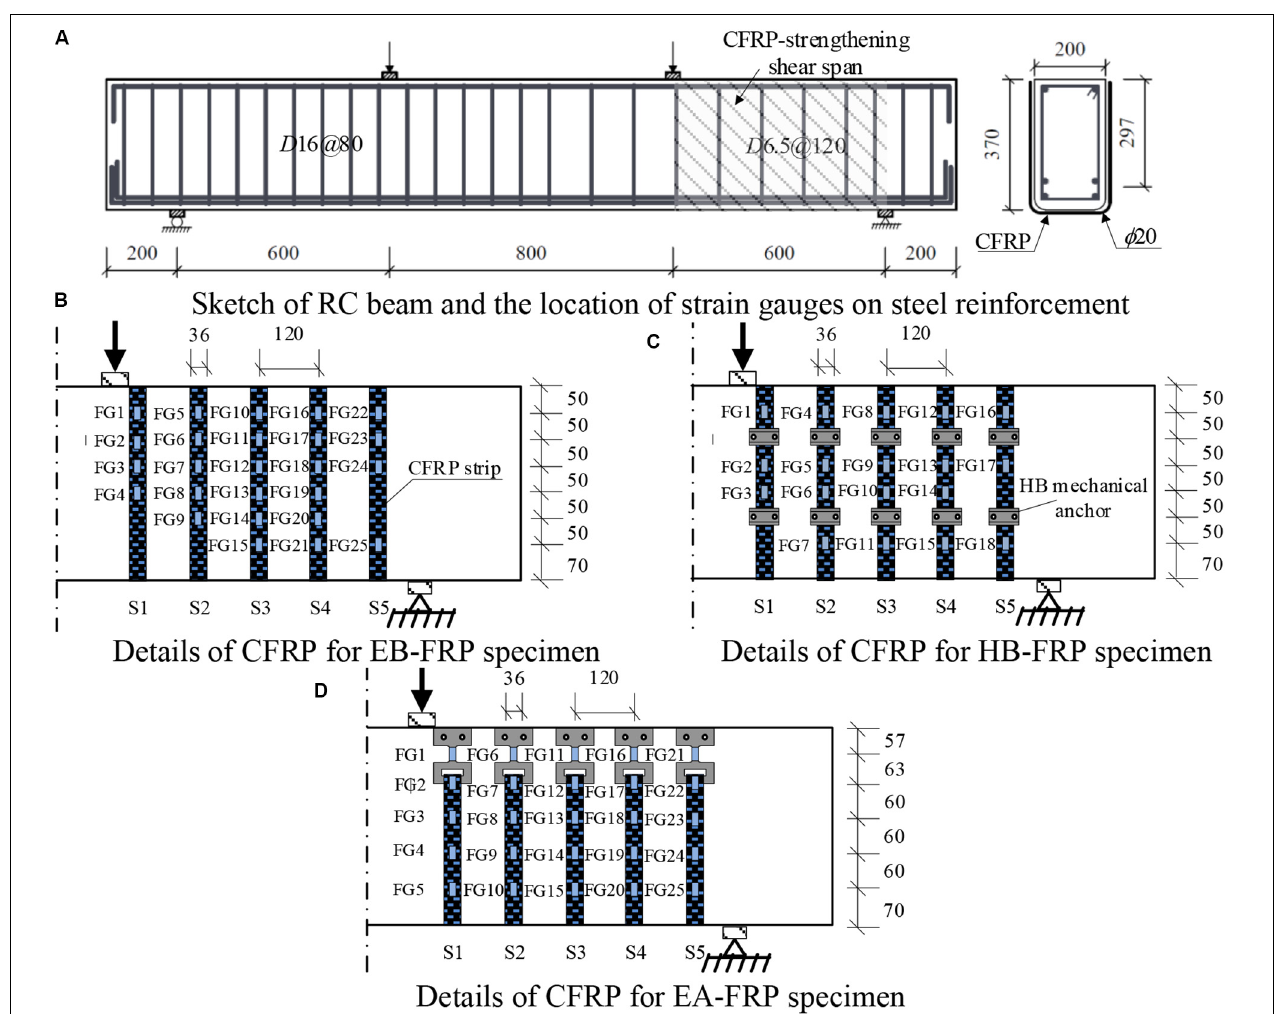
FIGURE 2 | Details of specimens and the location of CFRP strip and strain gauges. (A) Sketch of RC beam and the location of strain gauges on steel reinforcement. (B) Details of CFRP for EB-FRP specimen. (C) Details of CFRP for HB-FRP specimen. (D) Details of CFRP for EA-FRP specimen.